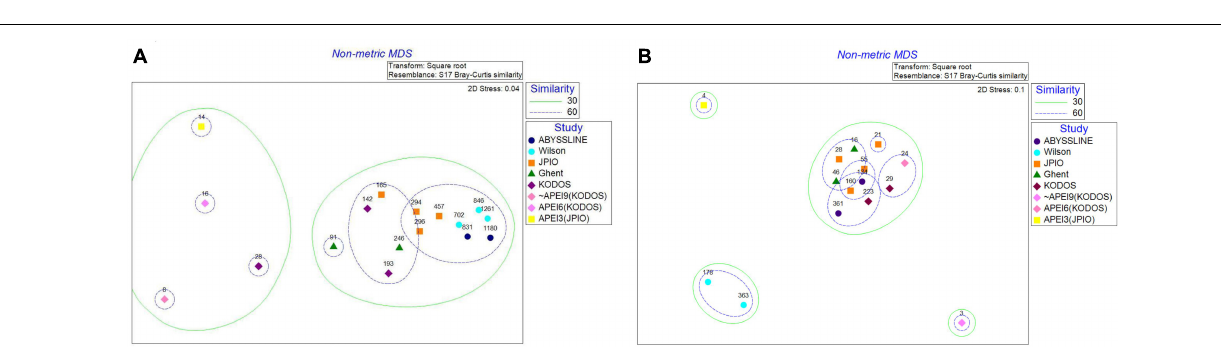
FIGURE 11 | Percent composition of polychaetes by family plotted on the regional map of POC flux. The percent abundance of the 10 most common families is shown, with the size of wedges of circles proportional to percent abundance. The center of each chart in the map indicates site location, with some offsets to allow all pie charts to be visible. See Supplementary Figure S2 for POC flux scale.